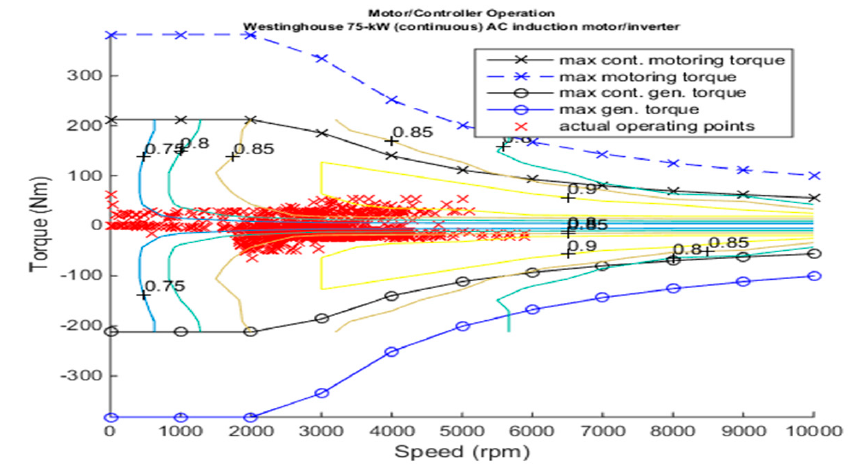
Figure 6. Motor torque-speed.